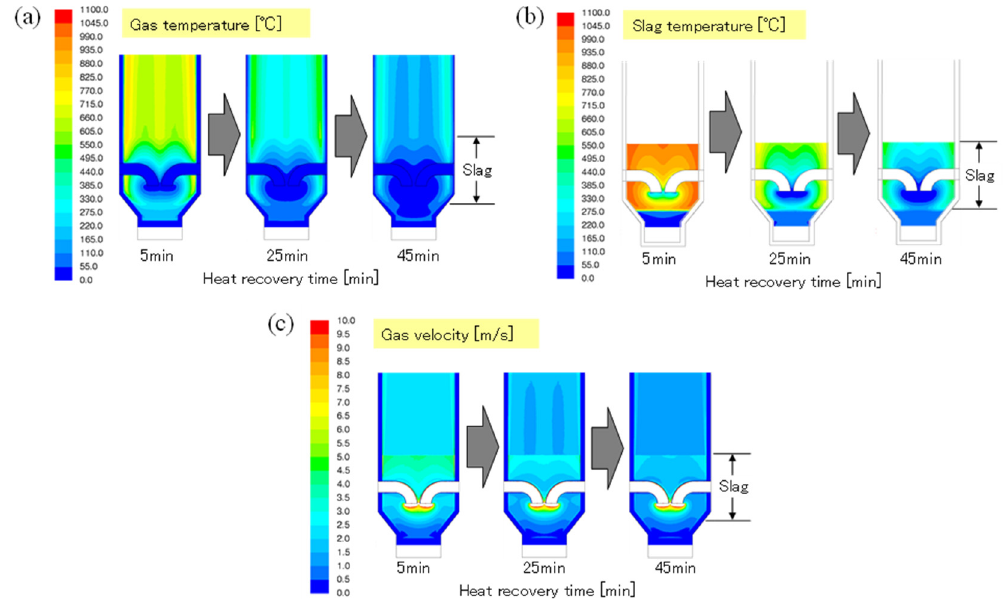
Figure 12. Result of Case 1 simulation: ( a ) gas temperature; ( b ) slag temperature and ( c ) gas velocity.